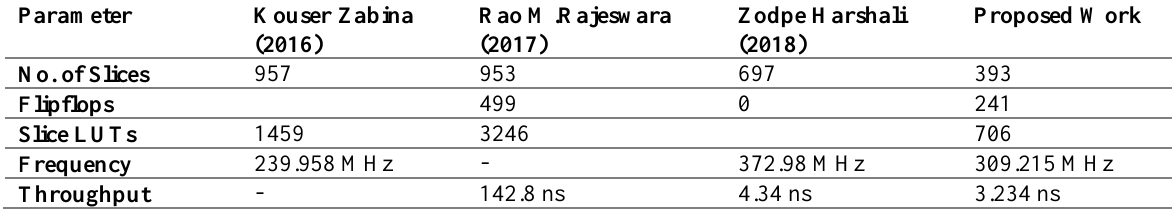
Table 6 Comparison with Existing AES Algorithm